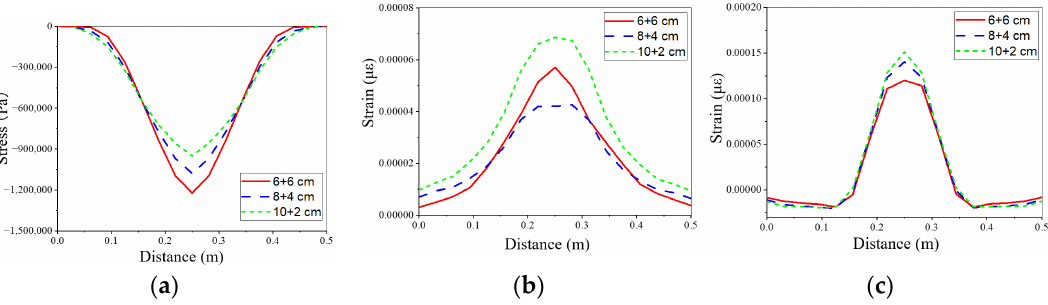
Figure 19. The effects of structural composites on the dynamic responses of ART pavement. ( a ) The longitudinal strain at the bottom of SFP. ( b ) The transverse strain at the bottom of SFP. ( c ) The vertical stress at the bottom of AC.